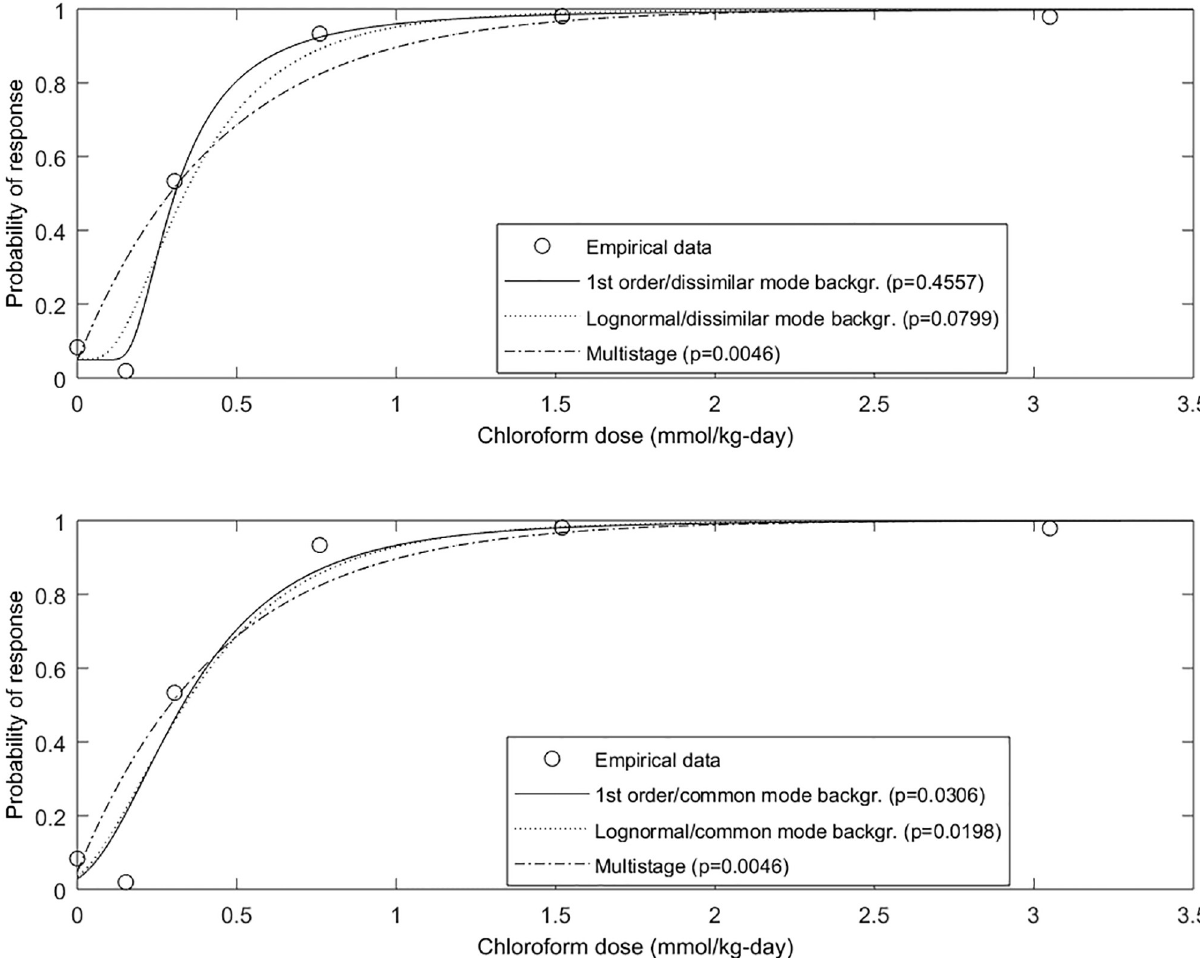
Fig 3. First-order/dissimilar-mode background (DMB), first-order/common-mode background (CMB), multi-stage, and lognormal DRFs versus data on chloroform-induced mild cellular liver necrosis in mice.